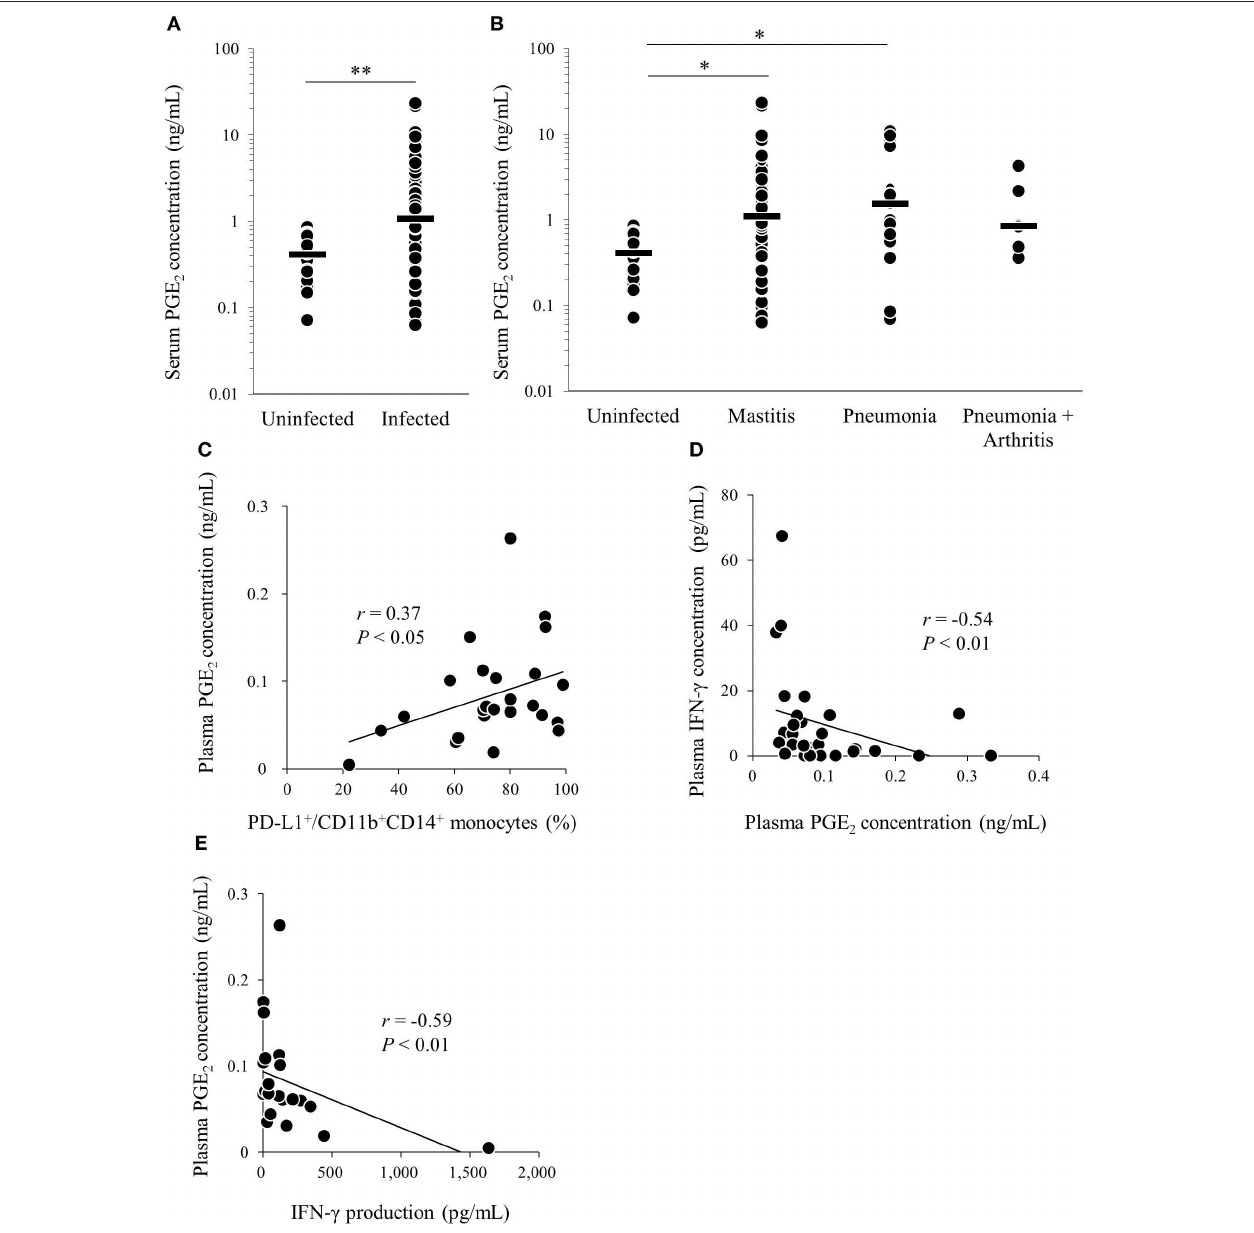
FIGURE 4 | Analysis of PGE 2 in cattle infected with M. bovis . (A,B) Serum PGE 2 levels in M. bovis -infected cattle ( n = 89; Mastitis: n = 62, Pneumonia: n = 21, Pneumonia with arthritis: n = 6) and uninfected cattle ( n = 18) was determined by ELISA. (C–E) Correlation between plasma PGE 2 levels in M. bovis -infected cattle with arthritis ( n = 13), otitis ( n = 10), pneumonia ( n = 5), and other factors. (C) Correlation between plasma PGE 2 levels and plasma IFN- γ levels ( n = 29). (D) Correlation between the plasma levels of PGE 2 and the proportions of PD-L1 + monocytes ( n = 25). (E) Correlation between plasma PGE 2 levels and IFN- γ production from PBMCs against heat-killed M. bovis ( n = 25). The bars are the median of the values (A,B) . Statistical significance was determined by the Mann–Whitney U -test (A) or the Steel–Dwass test (B) . Correlation statistics were analyzed using Spearman’s correlation analysis (C–E) . * P < 0.05, ** P <